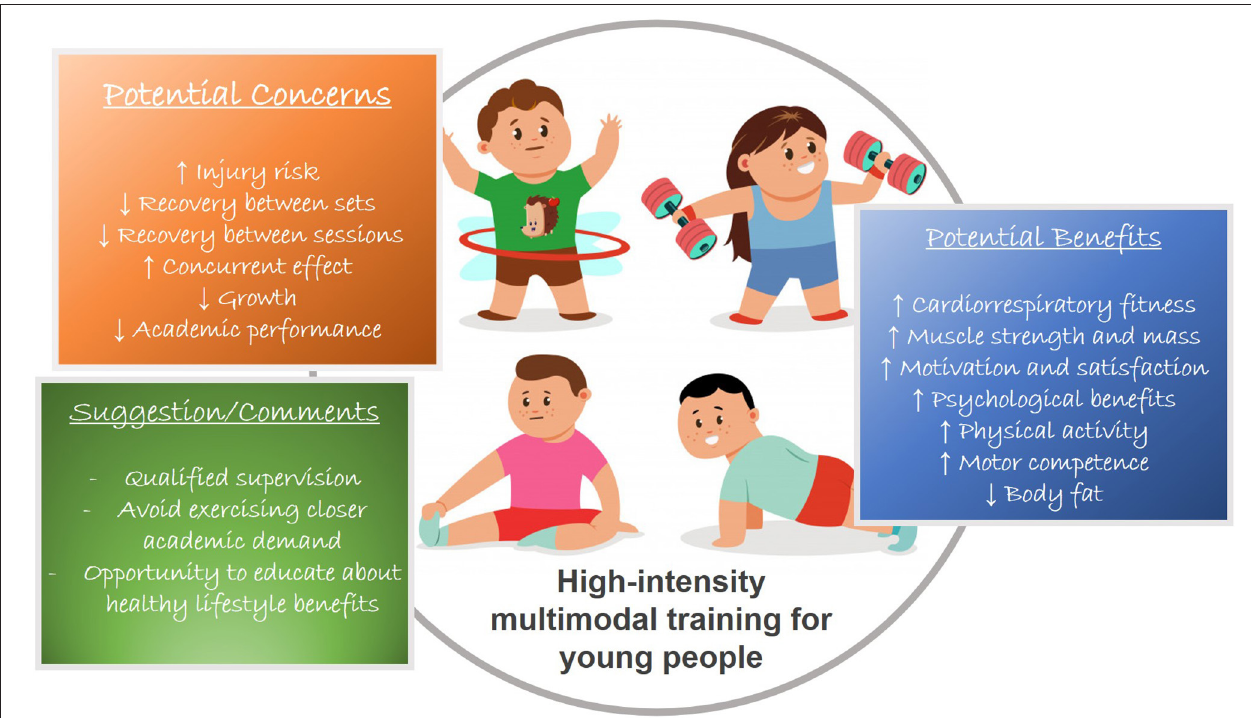
FIGURE 1 | Summary of benefits (Eather et al., 2016a,b), concerns (Hooper et al., 2014; Claudino et al., 2018; Garst et al., 2020), and suggestion/comments (Myer et al., 2011; Faigenbaum et al., 2016 ), regarding high-intensity multimodal training in young people.